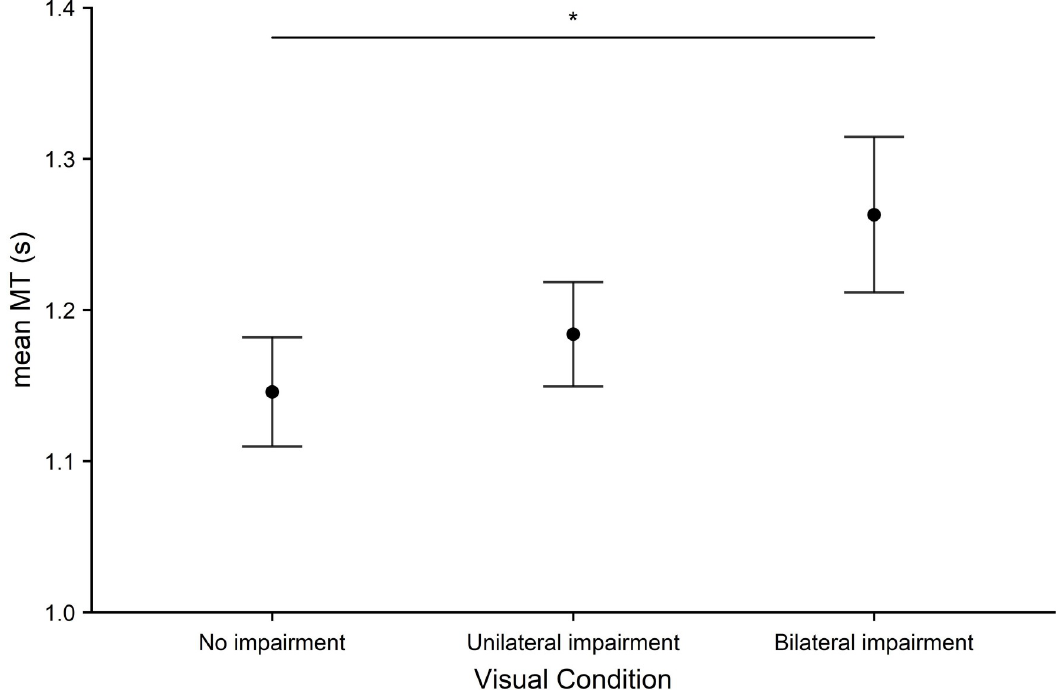
Fig 6. Aiming. Mean movement time (MT) in seconds across all visual conditions (no impairment, unilateral impairment, bilateral impairment). Error bars represent the standard error of the mean. Significant effects are represented as: p < 0.05 ( � ), p < .01 ( �� ), p < .001 ( ���